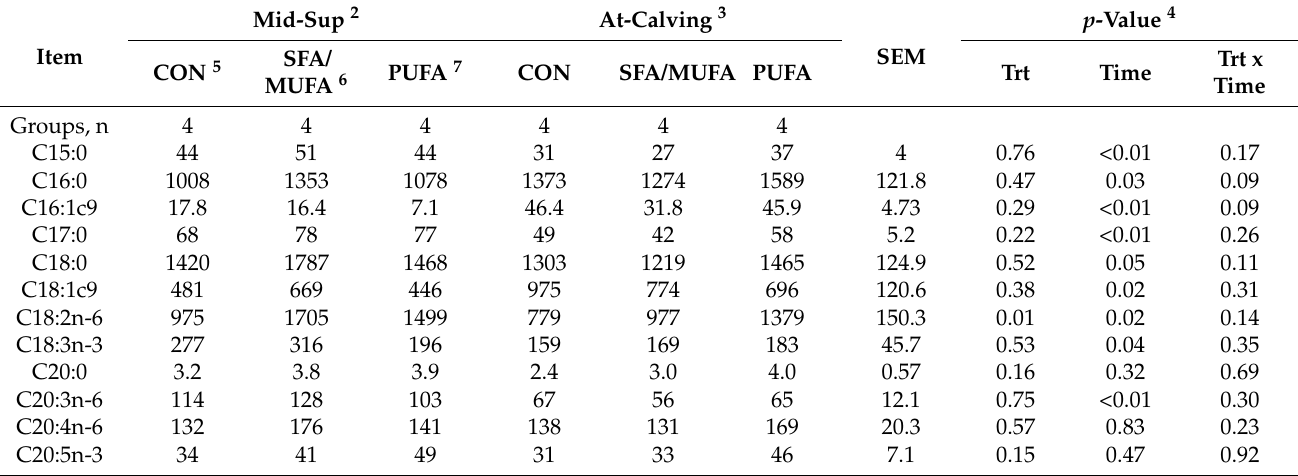
Table 5. Effects of supplementation for the last 82 ± 5 d of gestation of soybean hulls mixed with either whole-shelled corn (CRN), Ca salts of saturated/monounsaturated fatty acids (SFA/MUFA), or Ca salts of polyunsaturated fatty acids (PUFA2) on the relative concentrations of selected plasma fatty acids in cows 1